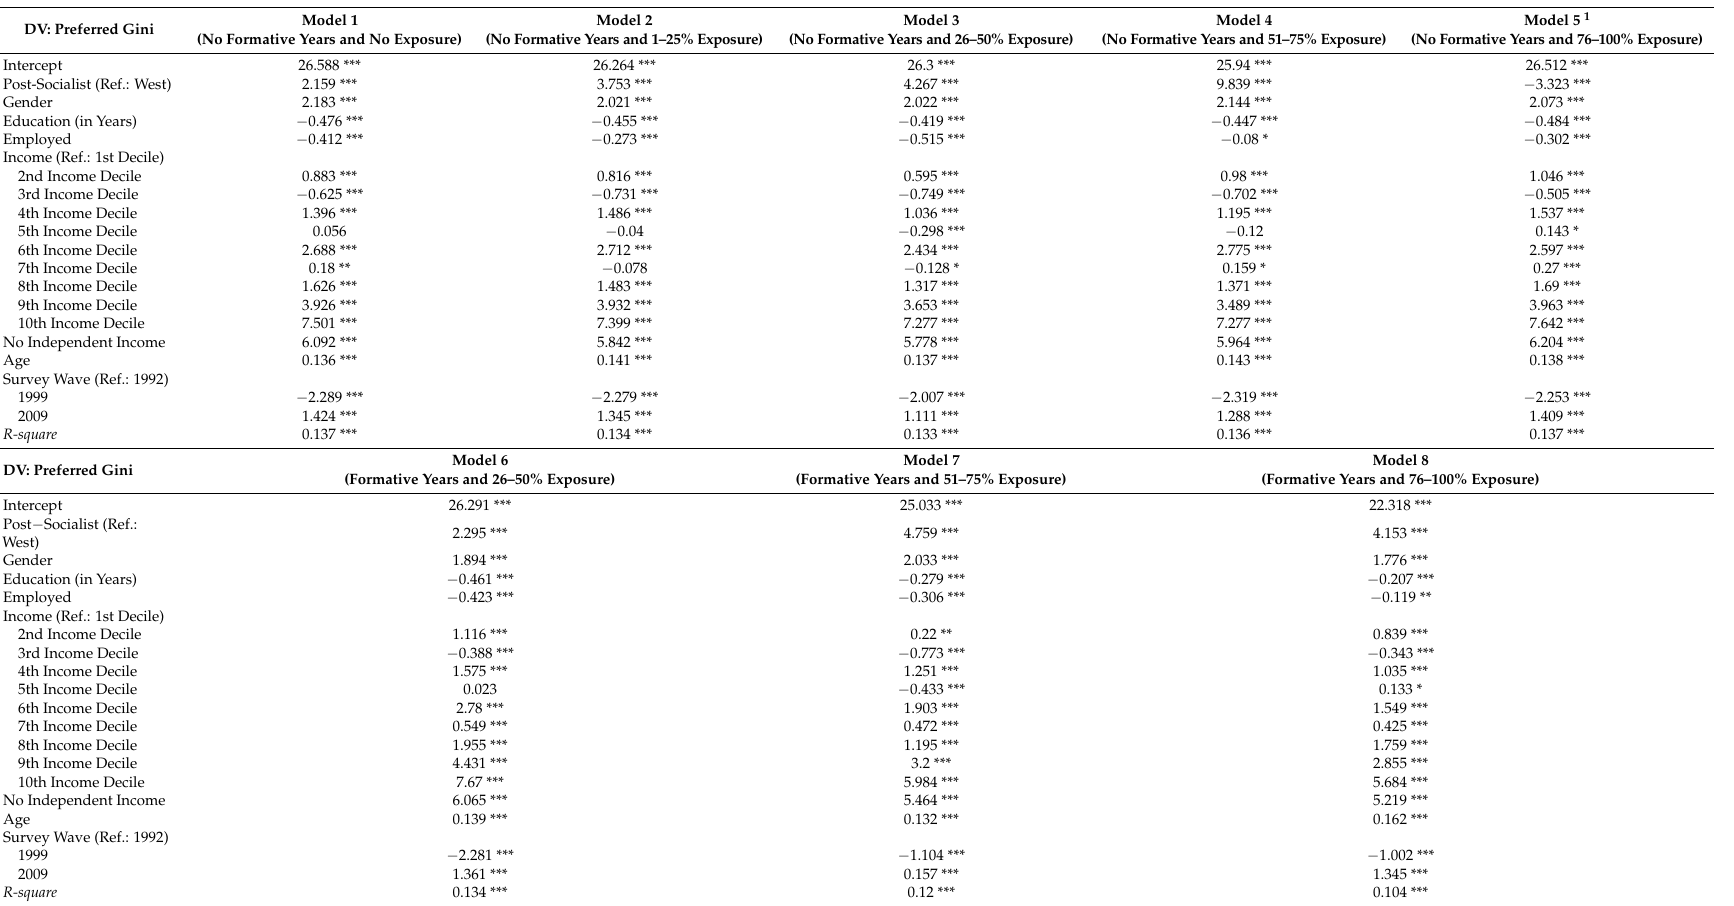
Table A9. Bootstrapped OLS regression models to explain the preferred Gini by exposure rate and formative years (corresponding with Figure 4c). DV: Preferred